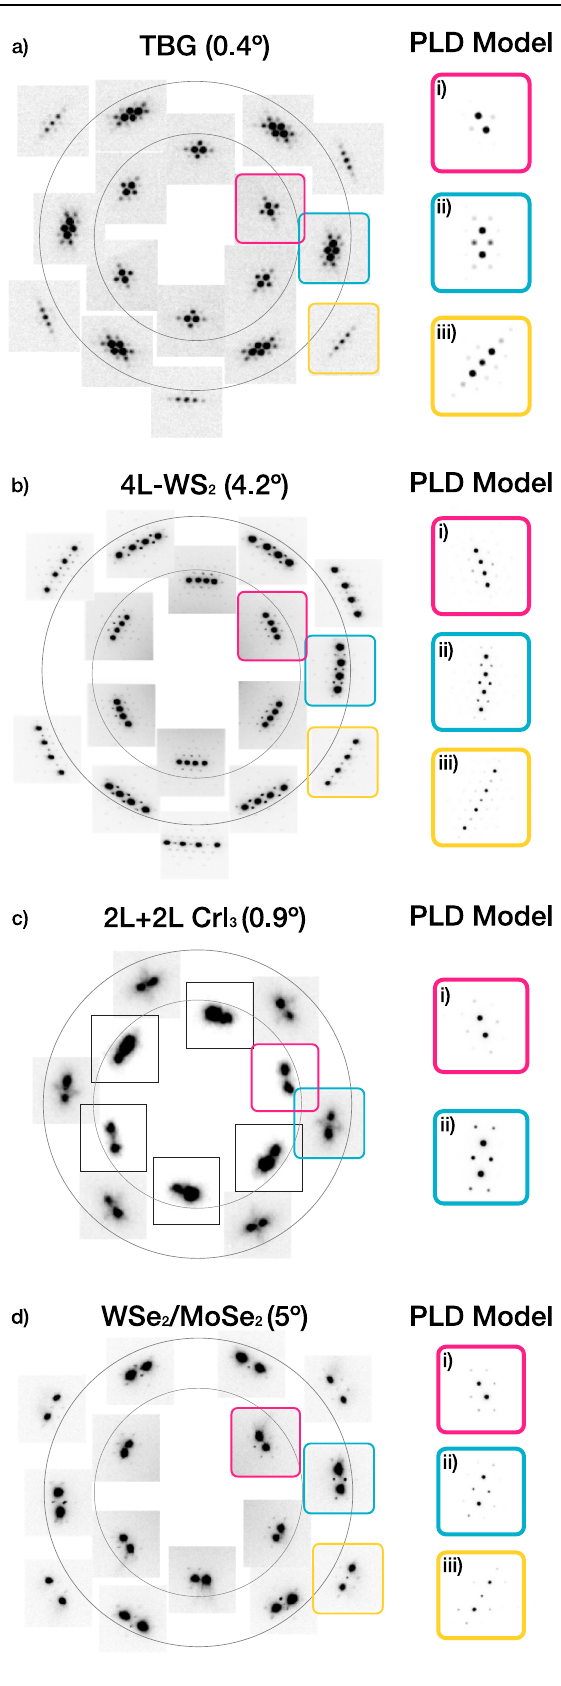
Fig. 5 | Universal torsional PLD relaxation of twisted 2D materials. Periodic relaxation is observed universally in multiple twisted 2D systems. SAED of a low- θ TBG, b twisted four-layer (4L) WS 2 homostructure, c twisted bilayer (2L+2L) CrI 3 , d twisted WSe 2 /MoSe 2 heterostructure shows bright Bragg peaks with small superlattice peaks. Insets i – iii are multislice simulated diffraction patterns with a torsional PLD model. The torsional PLD model reproduces qualitatively accurate SAED patterns across multiple